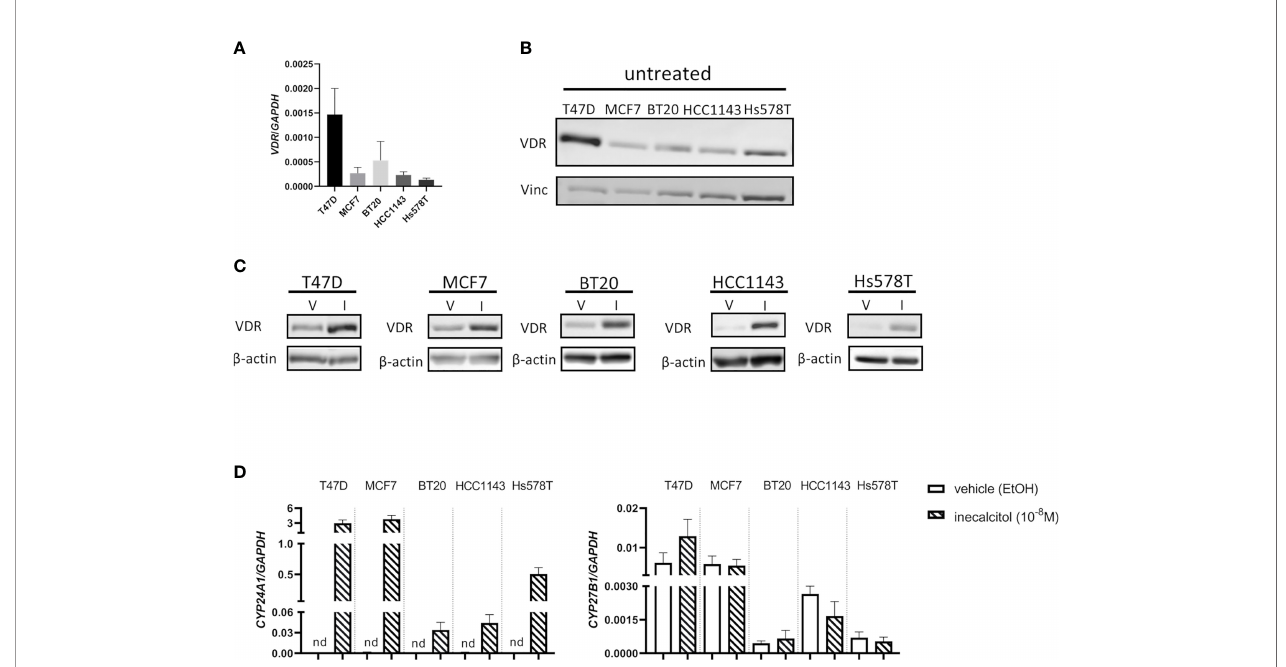
FIGURE 1 | VDR expression in the different BC cell lines. (A) VDR mRNA expression levels in T47D, MCF7, BT20, HCC1143 and Hs578T cells. Levels were normalized for GAPDH expression (n=3 performed in duplicate) (B) Basal VDR protein (49 kDa) expression in T47D, MCF7, BT20, HCC1143 and Hs578T cells. Vinculin (124 kDa) was used as loading control. (C) VDR protein (49 kDa) expression in the different cell lines after treatment with vehicle (V) (EtOH) or inecalcitol (I) (10 -8 M, 72 h). b -actin (42 kDa) was used as loading control. (D) CYP24A1 and CYP27B1 expression levels in T47D, MCF7, BT20, HCC1143 and Hs578T cells after treatment with vehicle or inecalcitol (10 -8 M, 72 h). Levels were normalized for GAPDH expression (n=2-5 performed in duplicate), nd: not